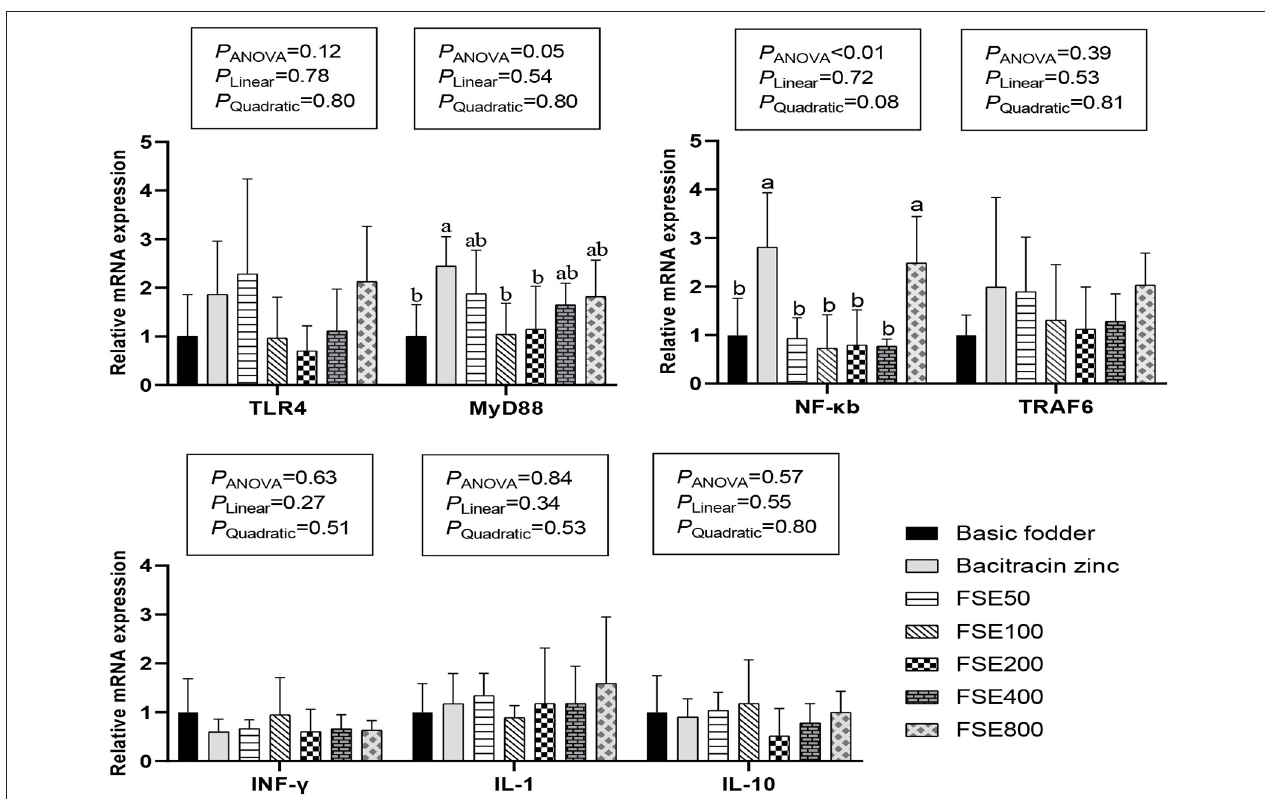
FIGURE 1 | Effects of fenugreek seed extract on gene expression of TLR4/MyD88/NF- κ B signaling pathway in spleen of